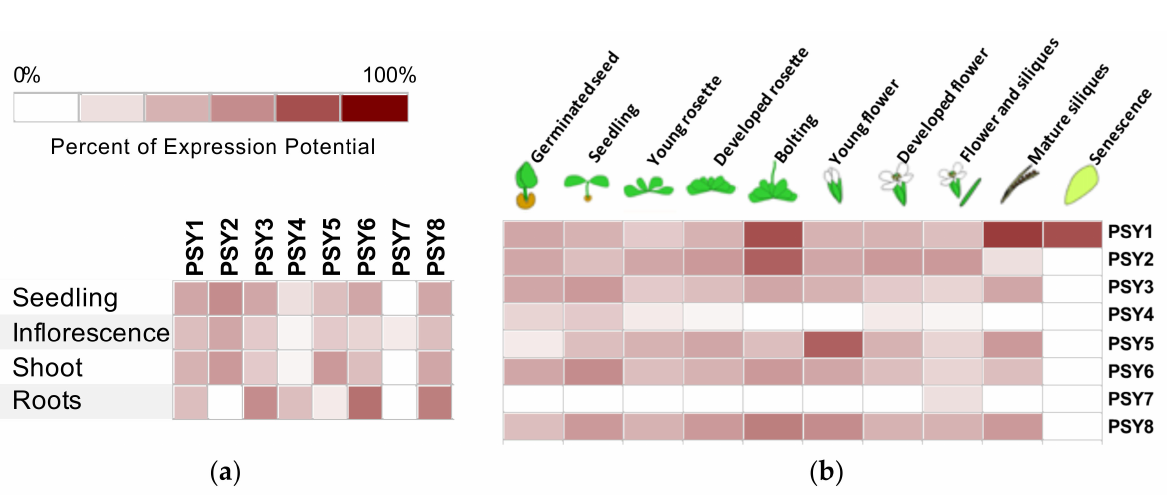
Figure 4. Transcript levels of PSY1-8 based on mRNAseq data from Genevestigator [41]. PSY expression in ( a ) different anatomical parts of the plant and ( b ) at different developmental stages. Expression is represented as percent of expression potential for each gene and presented on a log2 scale. 100% corresponds to maximal expression of a single gene. Only data for wildtype genotype and non-treated plants are